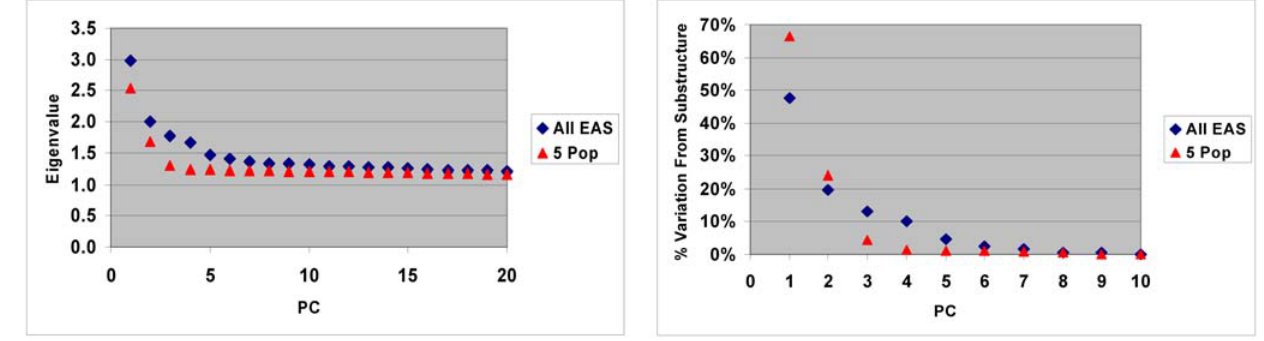
Figure 3. Eigenvalue distribution for principal components. A , The eigenvalues for each PC are shown for both the entire group of EAS (excluding Yakut), and for the five most populous ethnic groups (Chinese, Korean, Japanese, Filipino and Vietnamese). B , The proportion of the adjusted eigenvalue for each PC for the first 10 PCs is shown. For this measurement the PC10 eigenvalue for each group was used as the baseline. [Note: the eigenvalues plateau as shown in panel A and there is no discernable substructure beyond PC10 for these analyses ( Table 2 )]. For each PC, the PC10 eigen value was subtracted to determine an ‘‘adjusted’’ eigenvalue. The % substructure variation measurement was the proportion of each adjusted eigenvalue divided by the sum of the adjusted eigenvalues (PC1 through PC10).